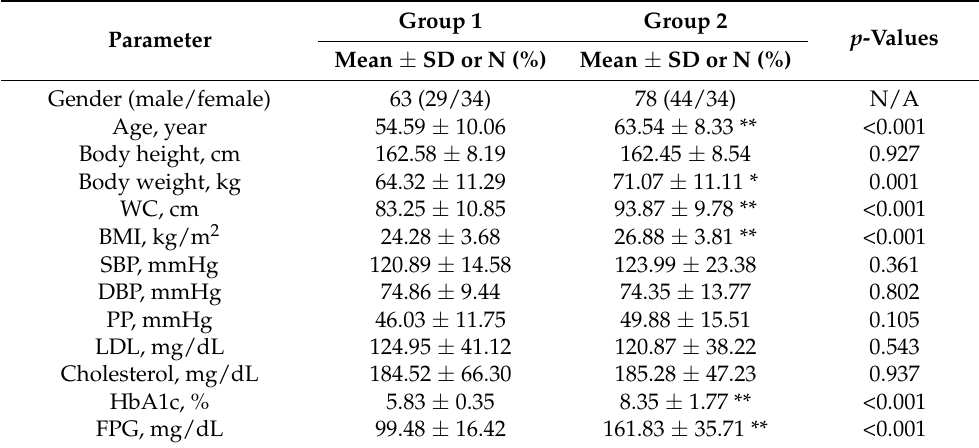
Table 1. Anthropometric and serum biochemical parameters from Group 1—healthy elderly subjects, and Group 2—diabetic